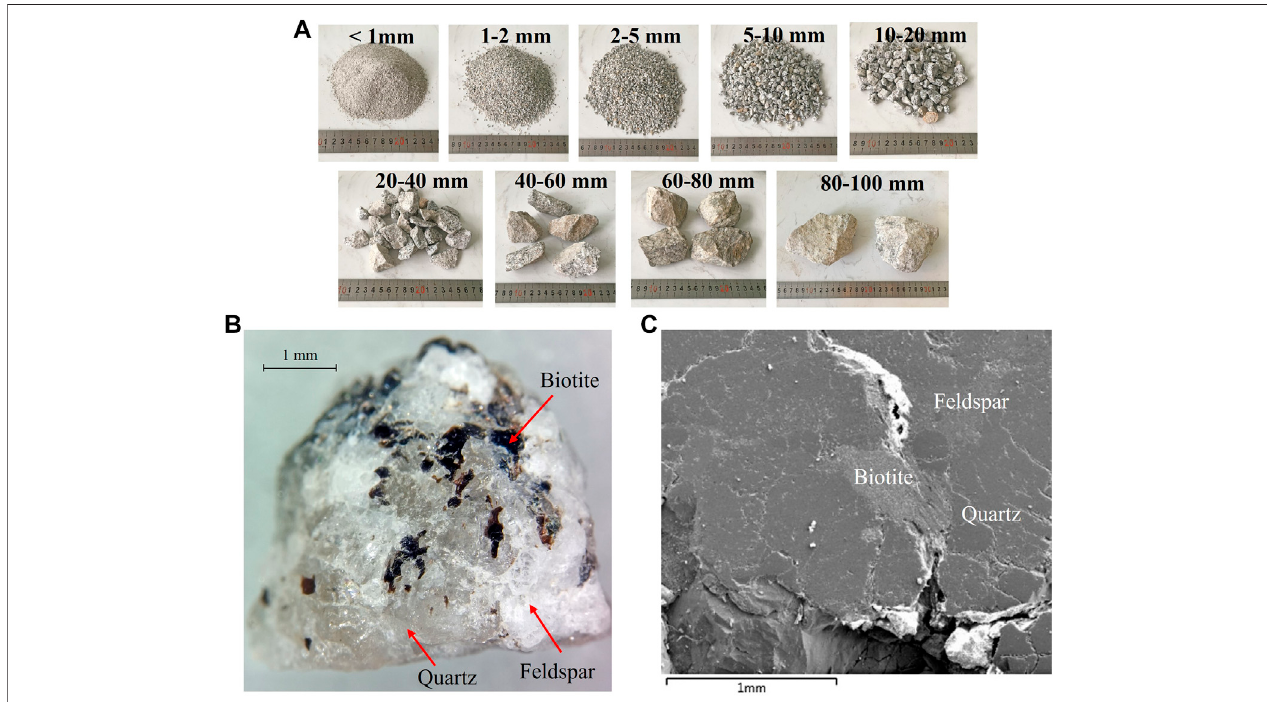
FIGURE1| Macroscopic observations on (A) Shuangjiangkourock fi llparticles ofsizes1 – 100 mm. Microscopic observations on Shuangjiangkou rock fi llparticles: (B) surface view with different mineral compositions; (C) FE-SEM image of one typical rock fi ll particle.